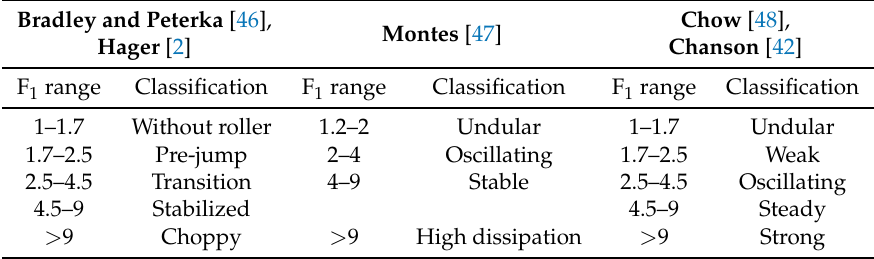
Table 1. Classic hydraulic jump (CHJ) typology according to several authors.